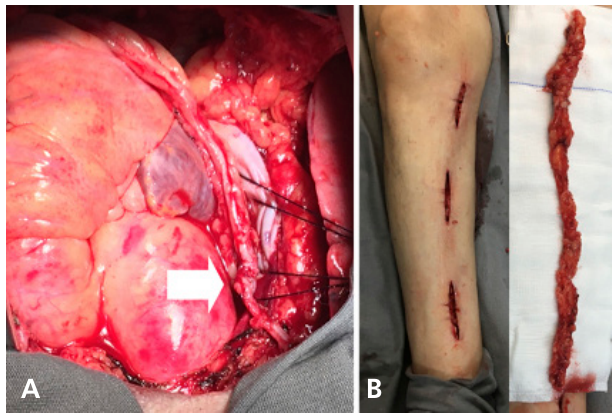
Fig. 6 - A. A no-touch saphenous vein grafted to the posterior descending coronary artery and proximally connected to the right internal thoracic artery stump (white arrow). B. The no-touch saphenous vein harvested through a minimally invasive